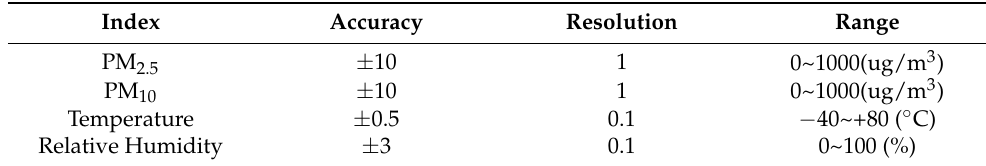
Figure 2. Air quality transmitter and temperature & humidity transmitter. Table 1. Some parameters of Jianda Renke Transmitter.